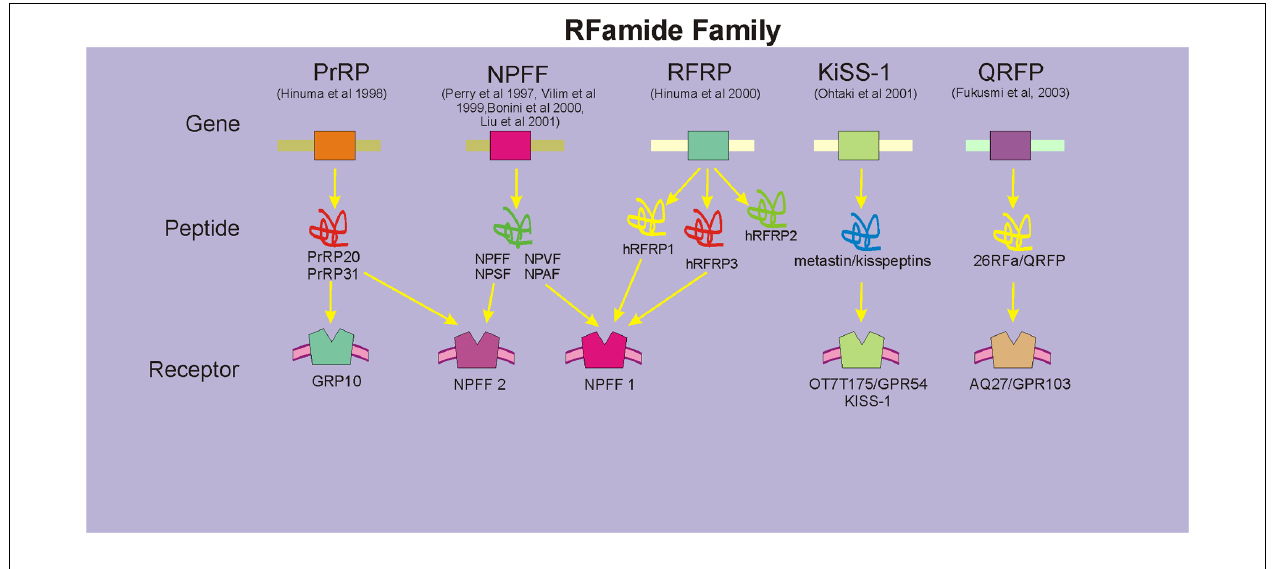
FIGURE 1 | Members of the mammalian RFamide family. These include the prolactin releasing peptide (PrRP) family, the family of NPFF (and related peptides NPAF, NPSF, and NPVF), human RFamide related peptides (hRFRPs),